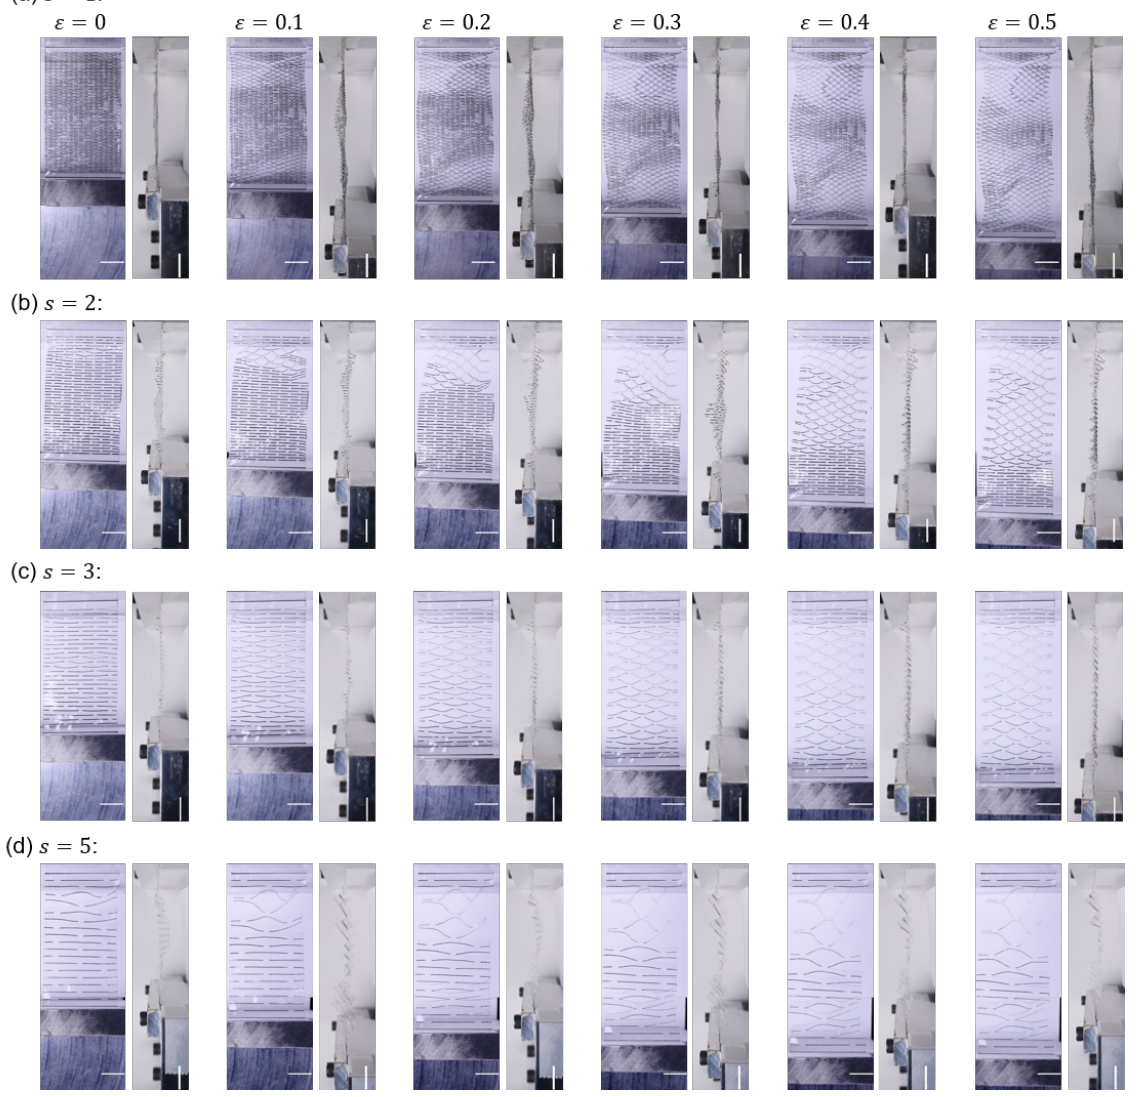
Figure 2. Sequential snapshots in the tensile loading to ε max = 0.5 without iteration (i.e., N c = 1) for different scale parameters s . Six sets of subfigures in each of ( a – d ) show the strain ε = 0,0.1,0.2,0.3,0.4, and 0.5 from left to right. A unit pair of subfigures for a specific strain value indicate the top and side views of the specimen. The scale bars indicate 10